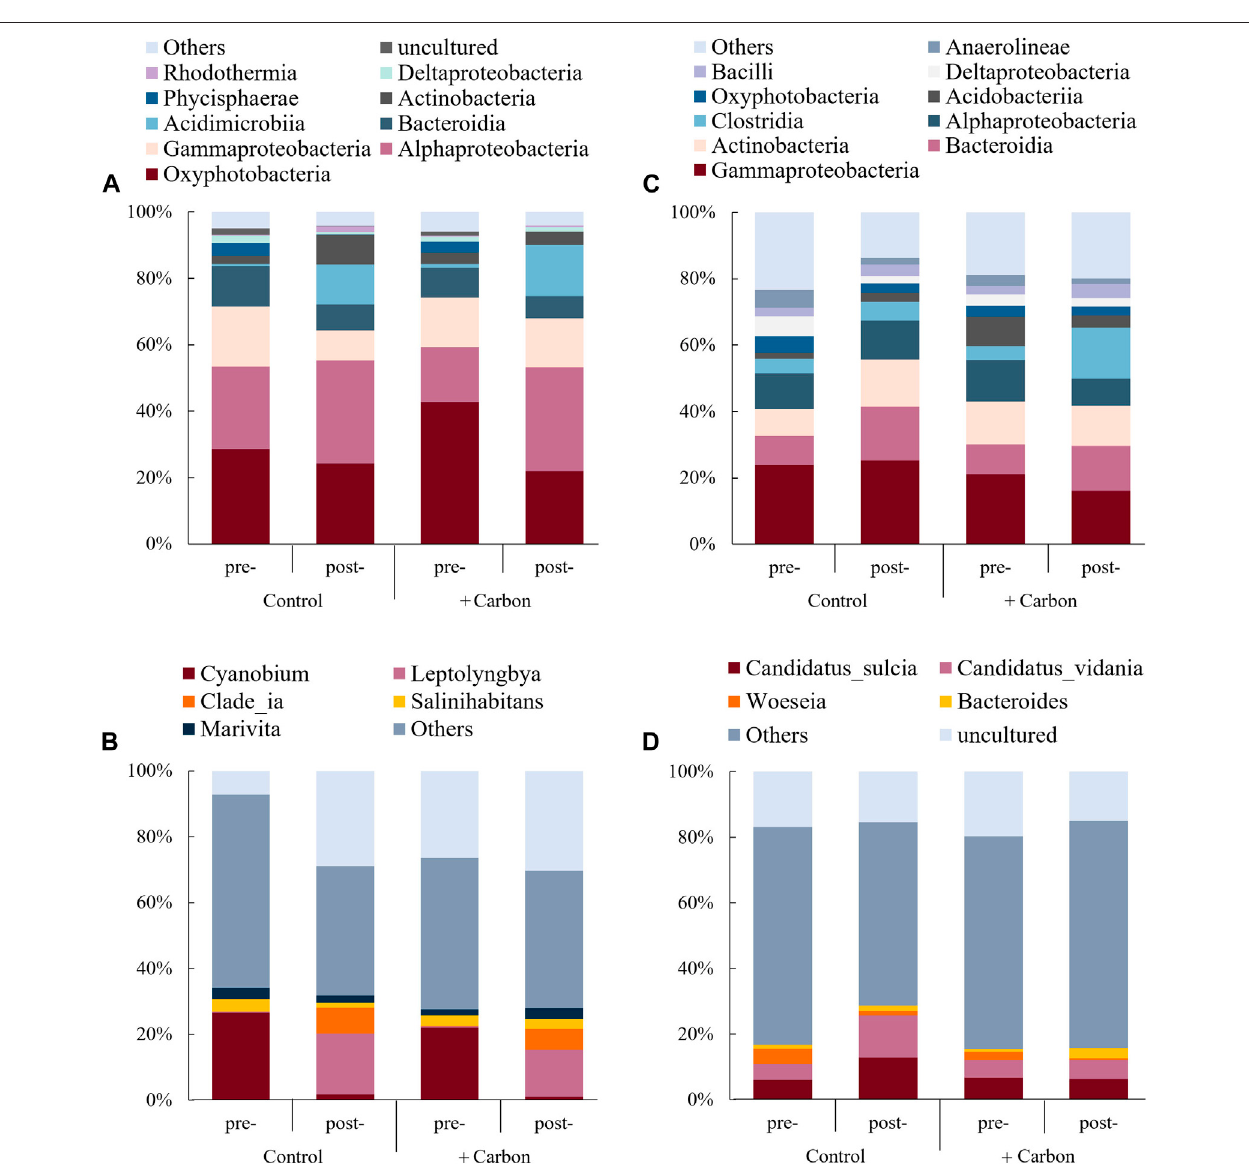
FIGURE 5 | The relative abundance of the top 10 classi fi ed bacterial classes (A) and genera (B) in overlying water, and bacterial classes (C) and genera (D) in sedimentforthevarioustreatmentsbefore(day1,codedaspre-Caddition)andaftercarbonaddition(day56,post-Caddition).Onlytheclassesandgenerawithrelative abundance higher than 1% in at least one sample were included for analysis. The abundance is presented in terms of an average percentage of the four replicates, classi fi ed by the RDP Classi fi er at a con fi dence threshold of 97%. “ Other ” refers to the sum of the unclassi fi ed sequences in each sample.